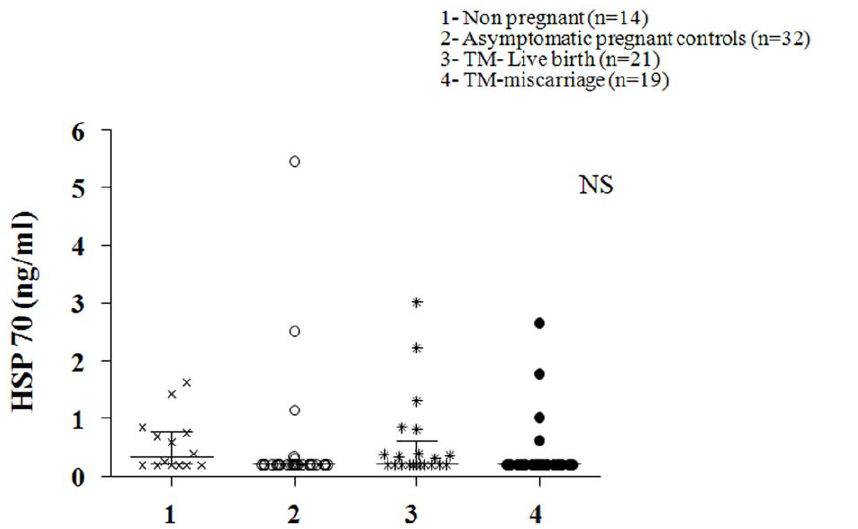
Figure 4. Scatter plot of circulating levels of serum heat shock protein 70 (Hsp 70) in the different groups of women with median and interquartile range. Group 1 (non-pregnant women, n=14), group 2 (normal pregnant women, n=32), group 3 (threatened miscarriage patients with a live birth outcome, n=21) and group 4 (threatened miscarriage patients with a subsequent miscarriage, n=19). General linear analysis of variance was carried out to study the statistical significance between the groups with posthoc tests. NS=not significant.